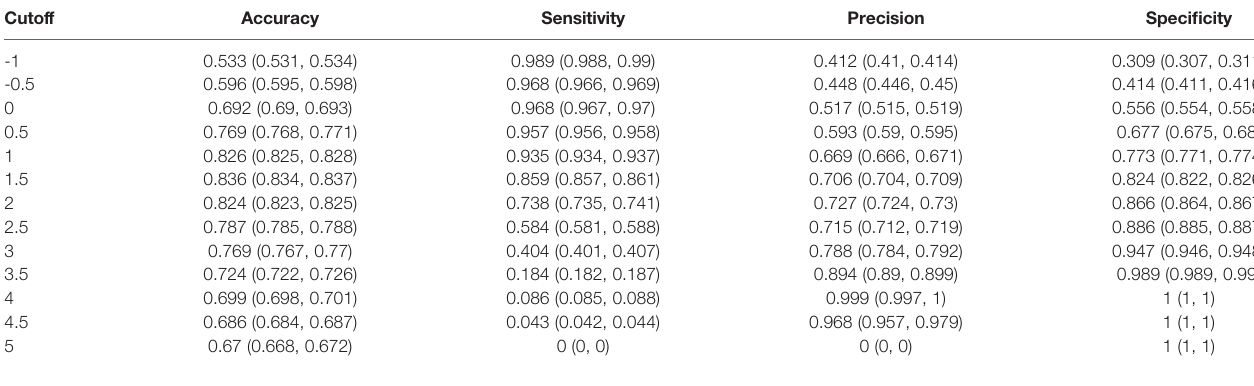
TABLE 3 | Cut-off values and corresponding performance data for the S2 scoring system based on three CT features, i.e., CT pre + Shape + Homogeneity (Homo), without enhanced CT features. Cutoff